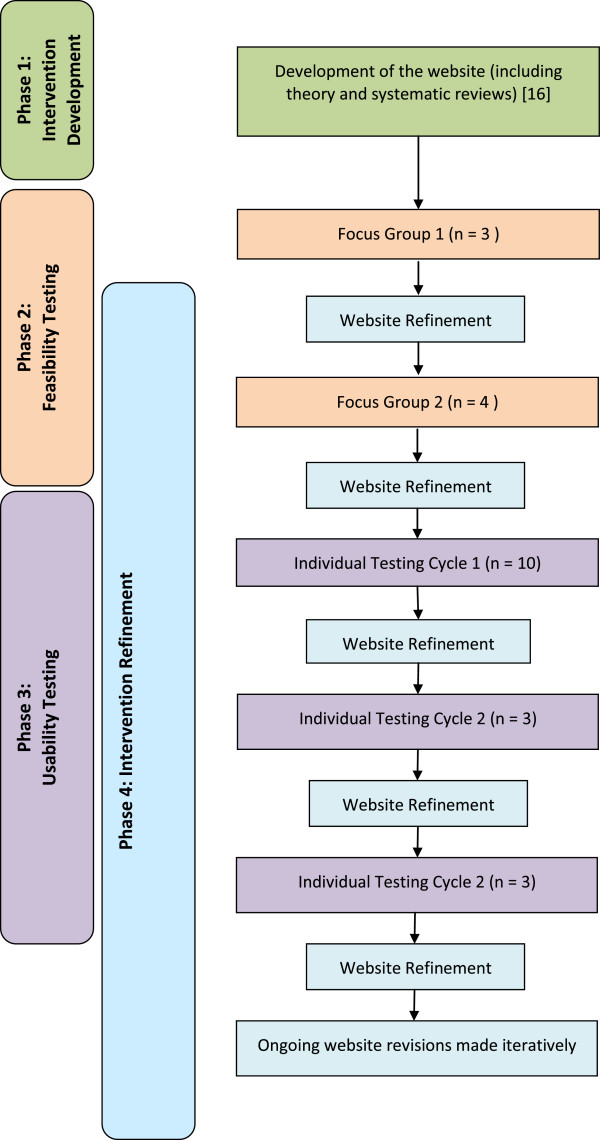
Study flow diagram.